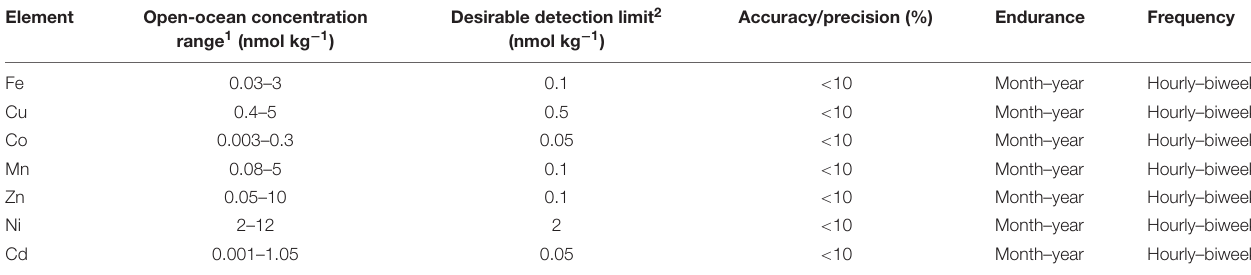
TABLE 1 | Ideal specifications of an autonomous observing system for metal micronutrients in the decade following OceanObs’19.